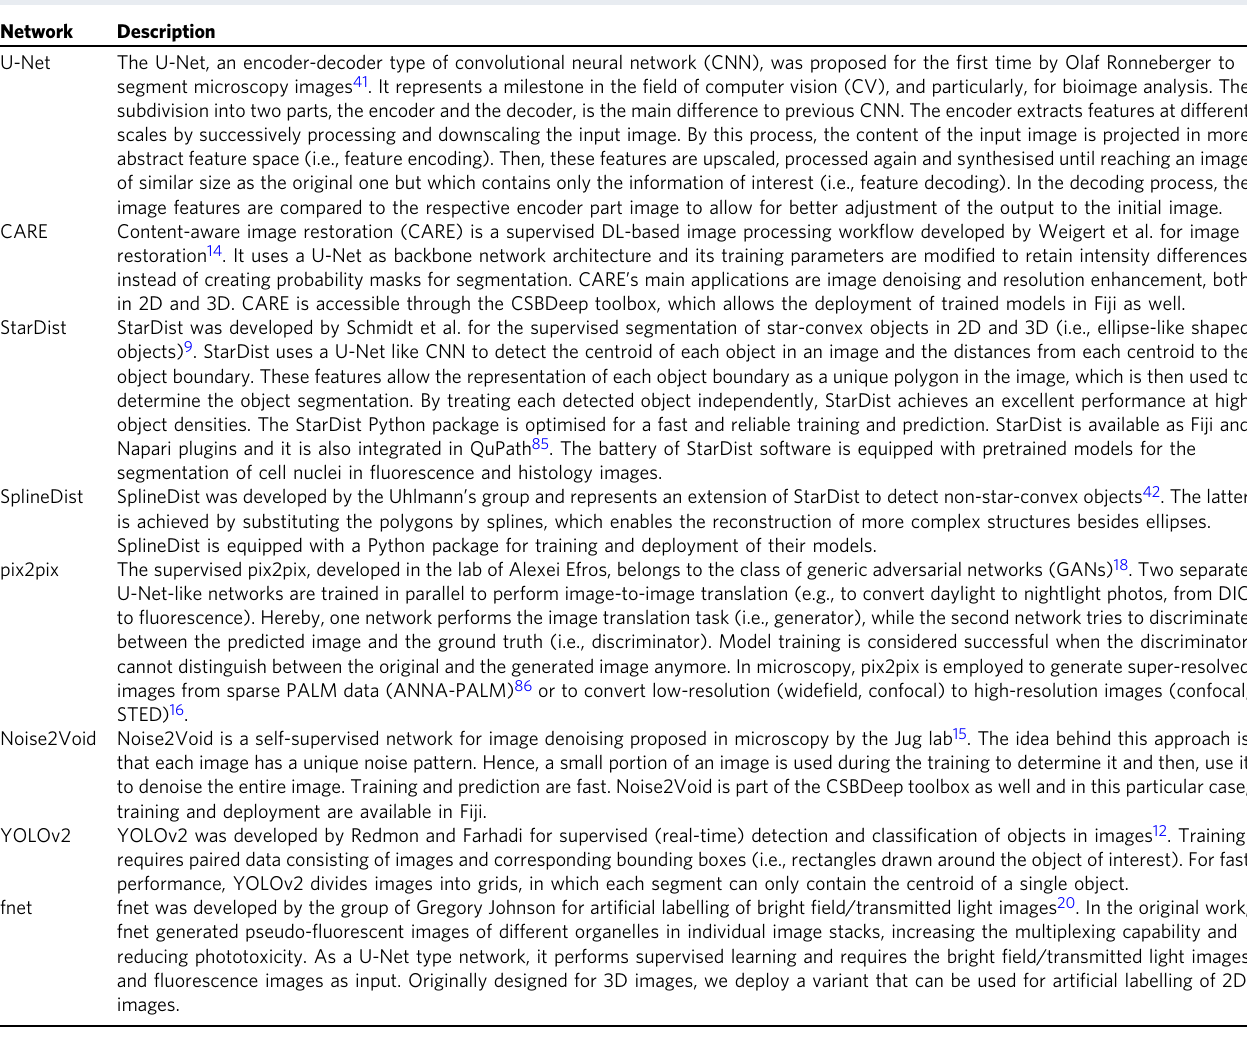
Table 1 Overview of the deep learning models used in this